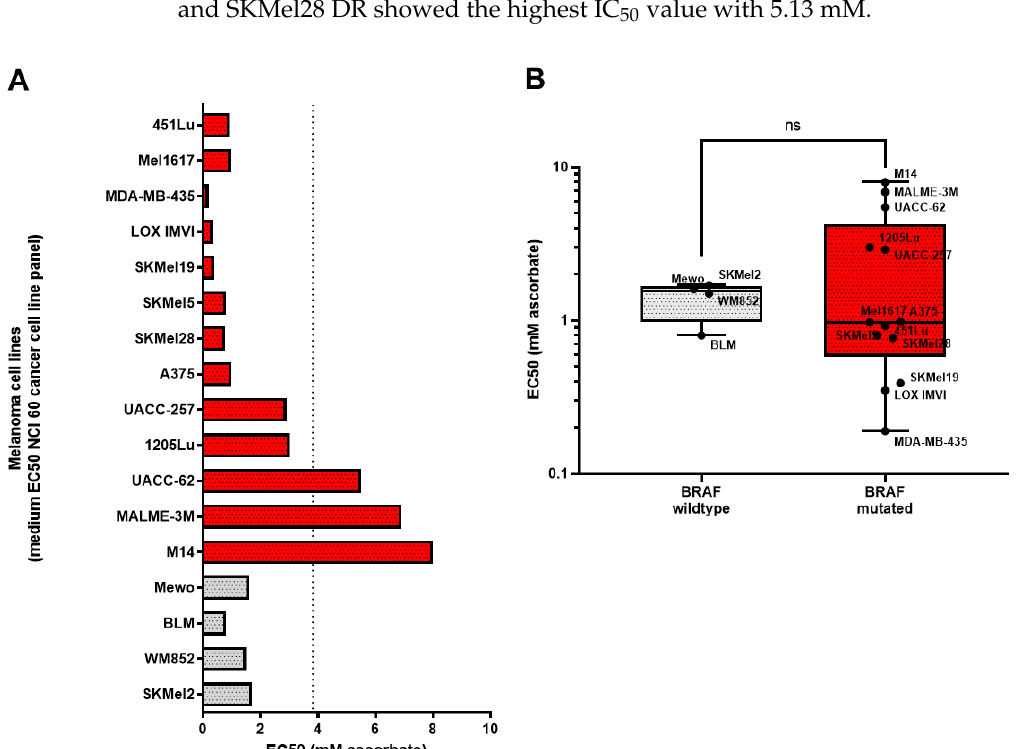
Figure 1. Growth inhibitory effects of ascorbate on melanoma cells. ( A ) EC50 of ascorbate treatment of melanoma cell lines including BRAF V600E mutated cell lines in red and BRAF wildtype cell lines in grey. ( B ) Median EC50 of ascorbate treatment from BRAF V600E mutated melanoma cells (red) was compared to the median EC50 of ascorbate treatment from BRAF wildtype melanoma cell lines (grey). p -value was calculated using the two-tailed Mann–Whitney test. ns: p > 0.05.